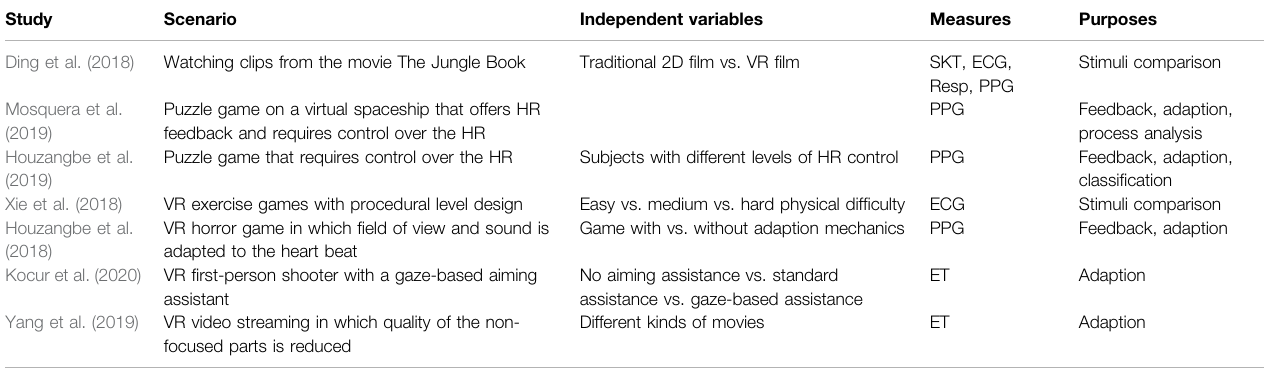
TABLE7| Overviewoftheworksfromthe fi eldofentertainmentthatwerediscussedin Section4.1.3 .TheMeasurescolumnreferstothephysiologicalmeasuresusedinthe work. The entries of the Independent Variables column often do not cover everything that was considered in the work. Entries in the Purposes column refer to the categories listed in Section 4.1.6